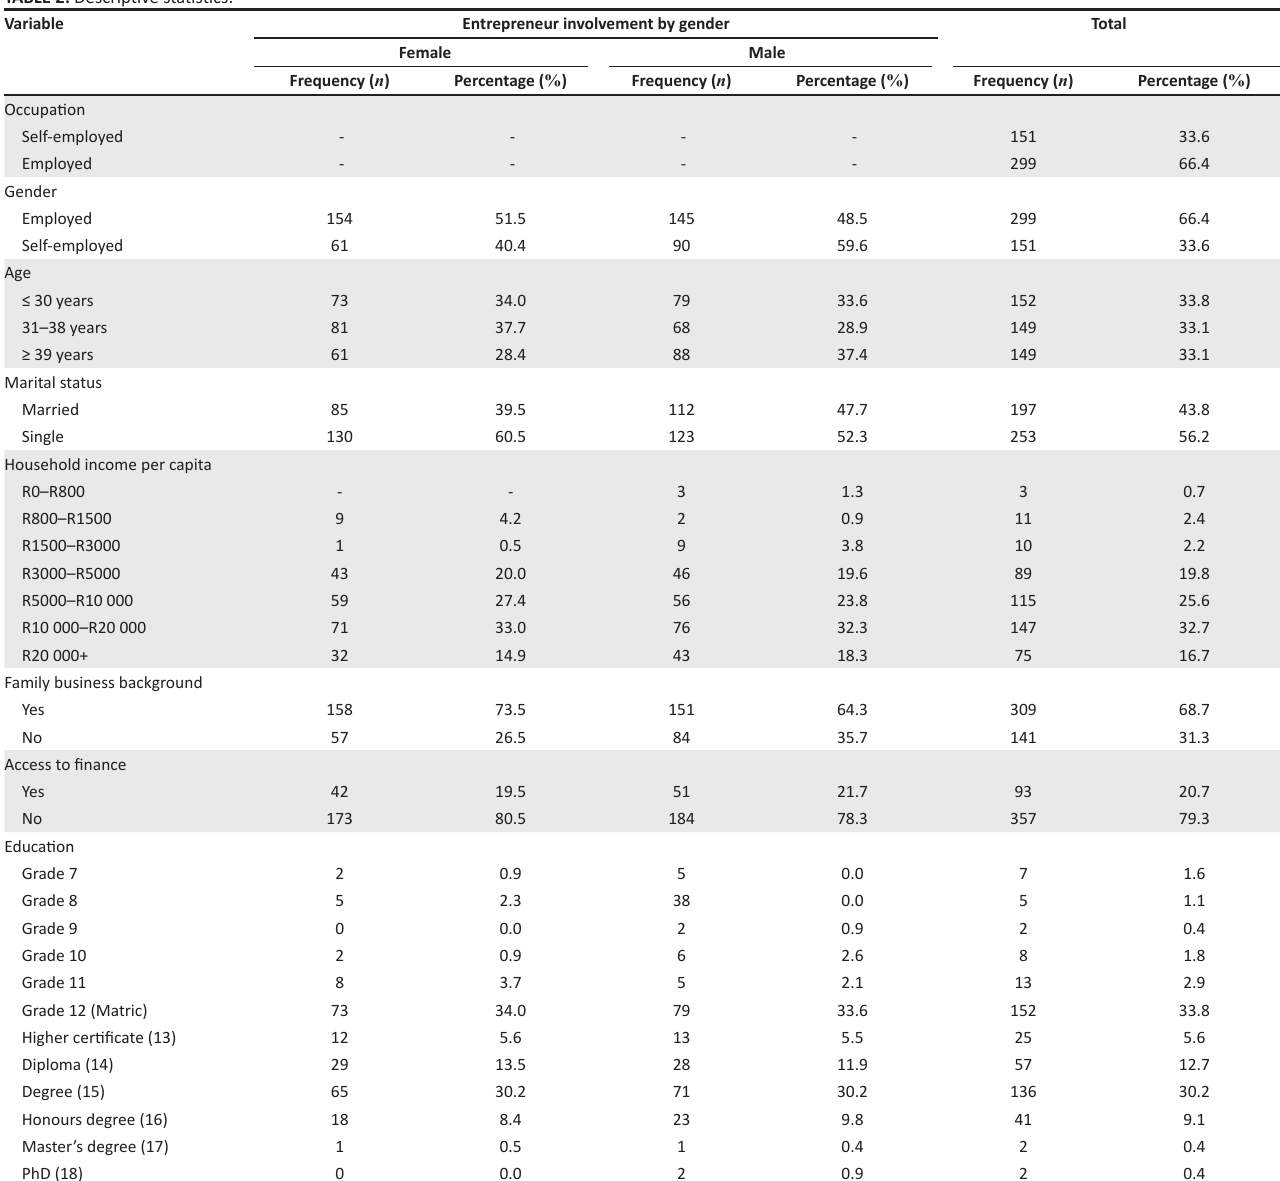
TABLE 2: Descriptive